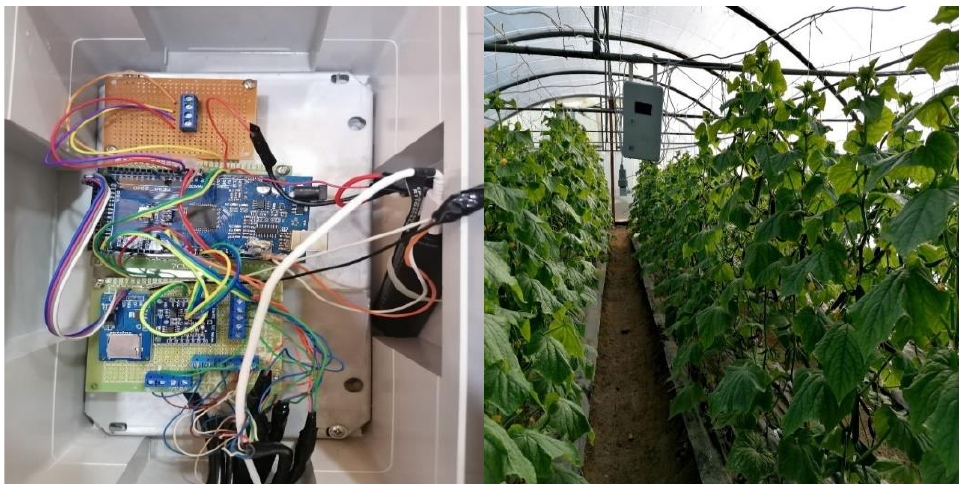
Figure 2. Actual prototype of the Arduino microcontroller system installed inside the greenhouse.